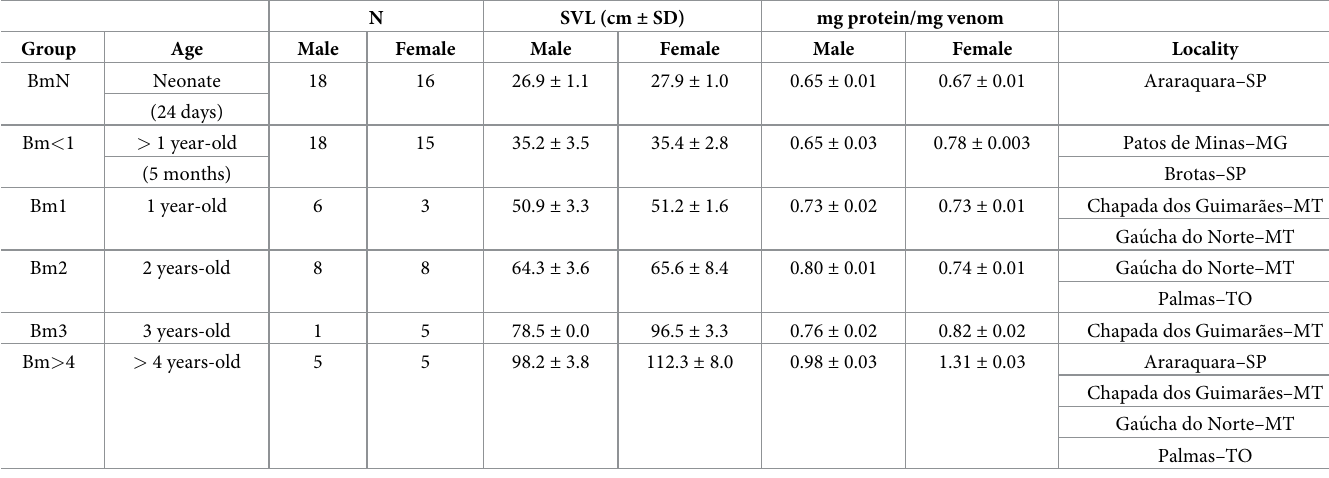
Table 1. Data of age, size, and localization where the snakes or their parents came from.